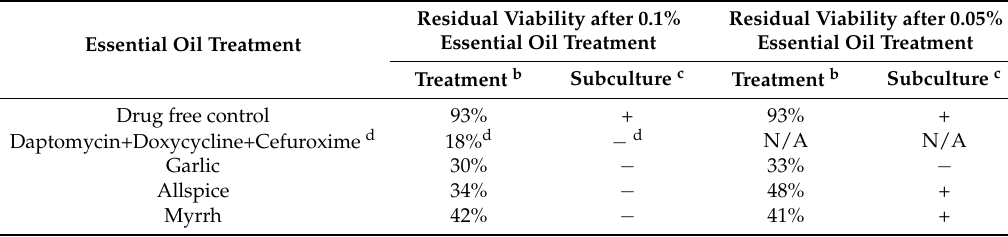
Table 2. Comparison of top 10 essential oil activities against stationary phase B. burgdorferi with 0.1% and 0.05% ( v/v ) treatment and subculture a .